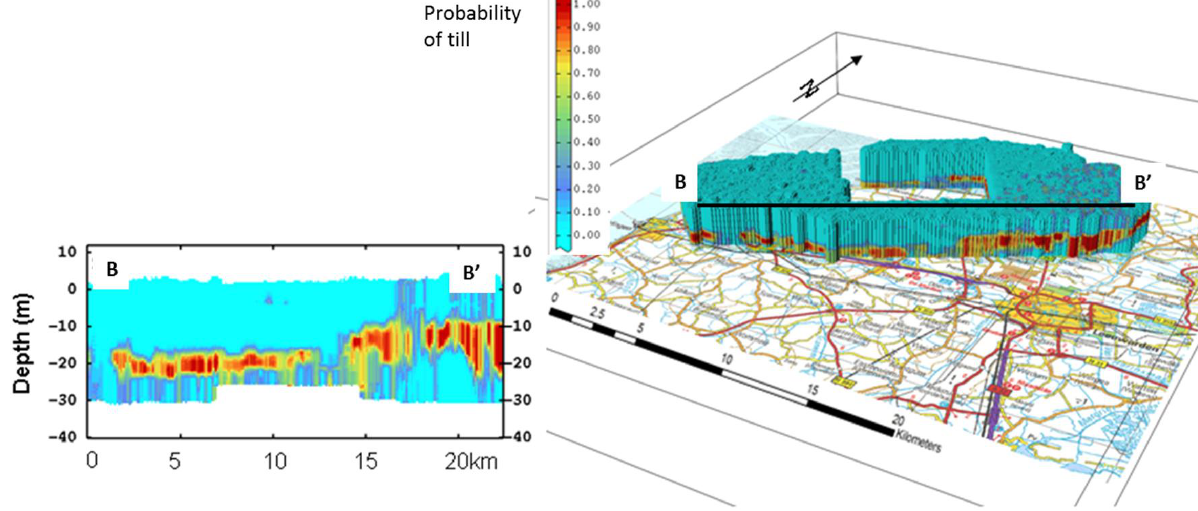
Fig. 5. Probability of glacial till, as derived from AEM models (in this case the results of the HEM are